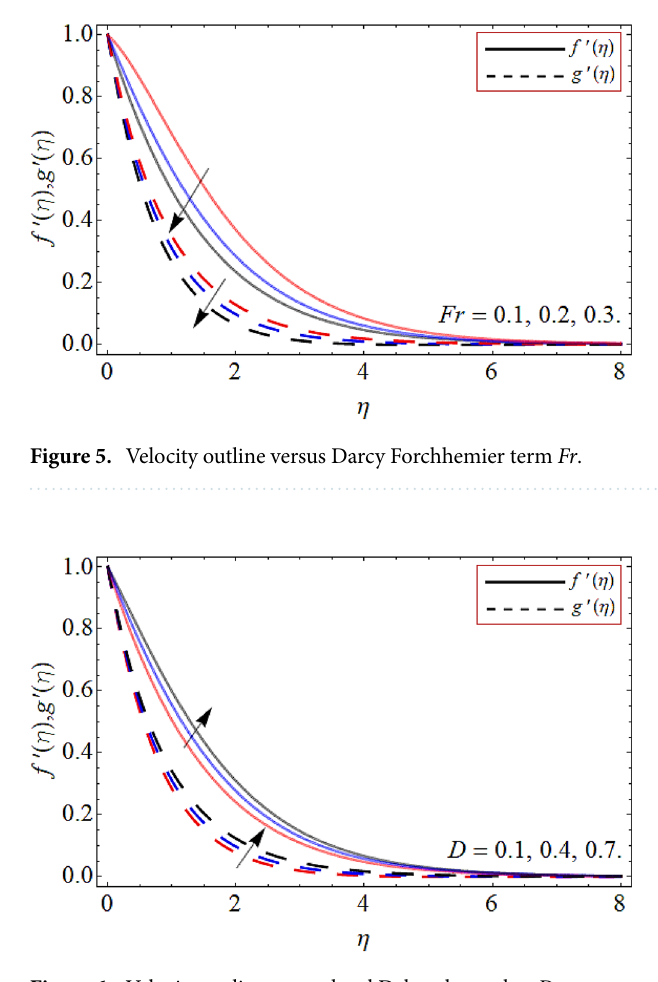
Figure 6. Velocity outline versus local Deborah number D .